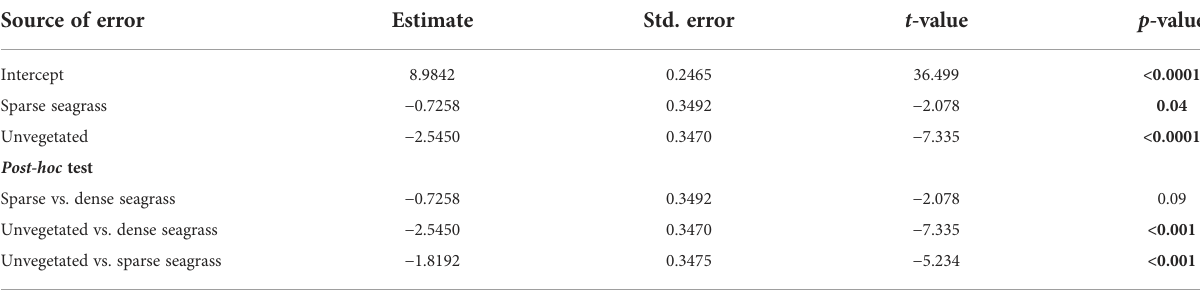
Unvegetated vs. sparse